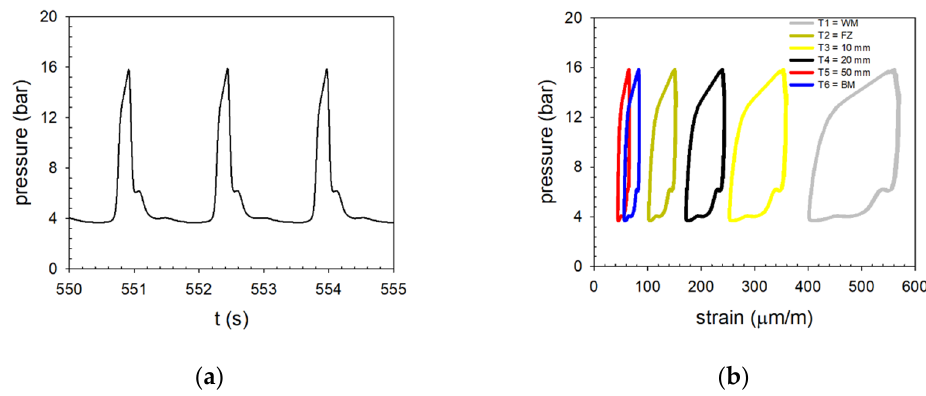
Figure 11. ( a ) Pressure-time and ( b ) pressure-strain curve at high-cycle fatigue pressure test.